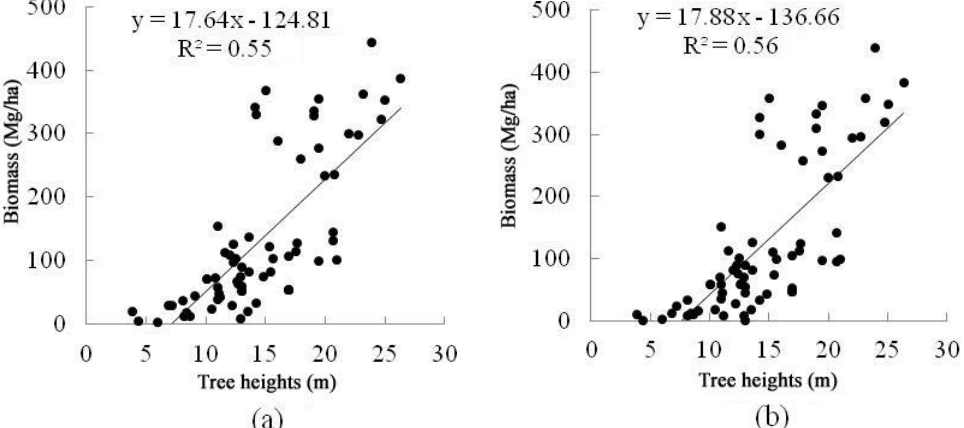
Figure 2. The relationships of biomass and tree heights. ( a ) Original biomass model vs. tree heights and ( b ) modified biomass model vs. tree heights ( n = 65).